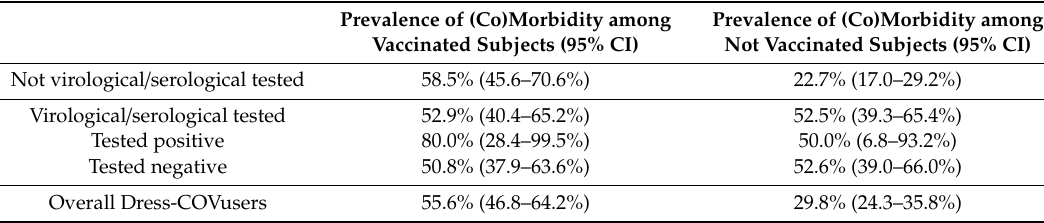
Table 1. Dress-COV: prevalence of morbidity among vaccinated and not vaccinated users. Prevalence of (Co)Morbidity among Prevalence of (Co)Morbidity among Vaccinated Subjects (95% CI) Not Vaccinated Subjects (95%